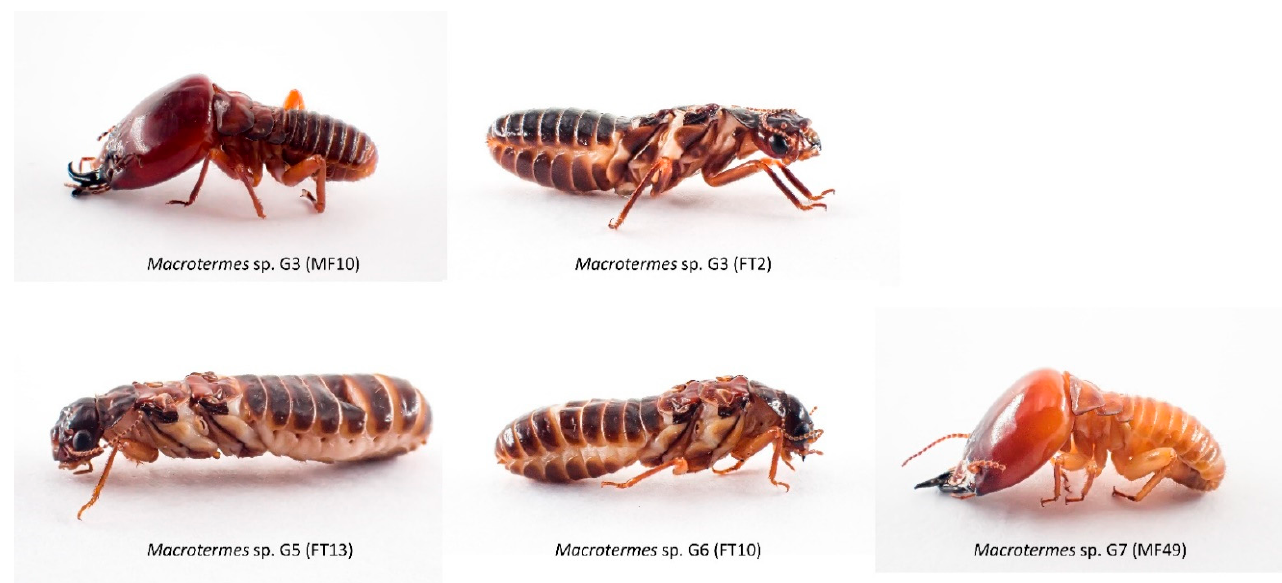
Figure 5. Representative specimens of Macrotermes termites collected in Limpopo, South Africa. G3, G5, G6 and G7 represent the genetic groups found in the region (specimen code in parenthesis).